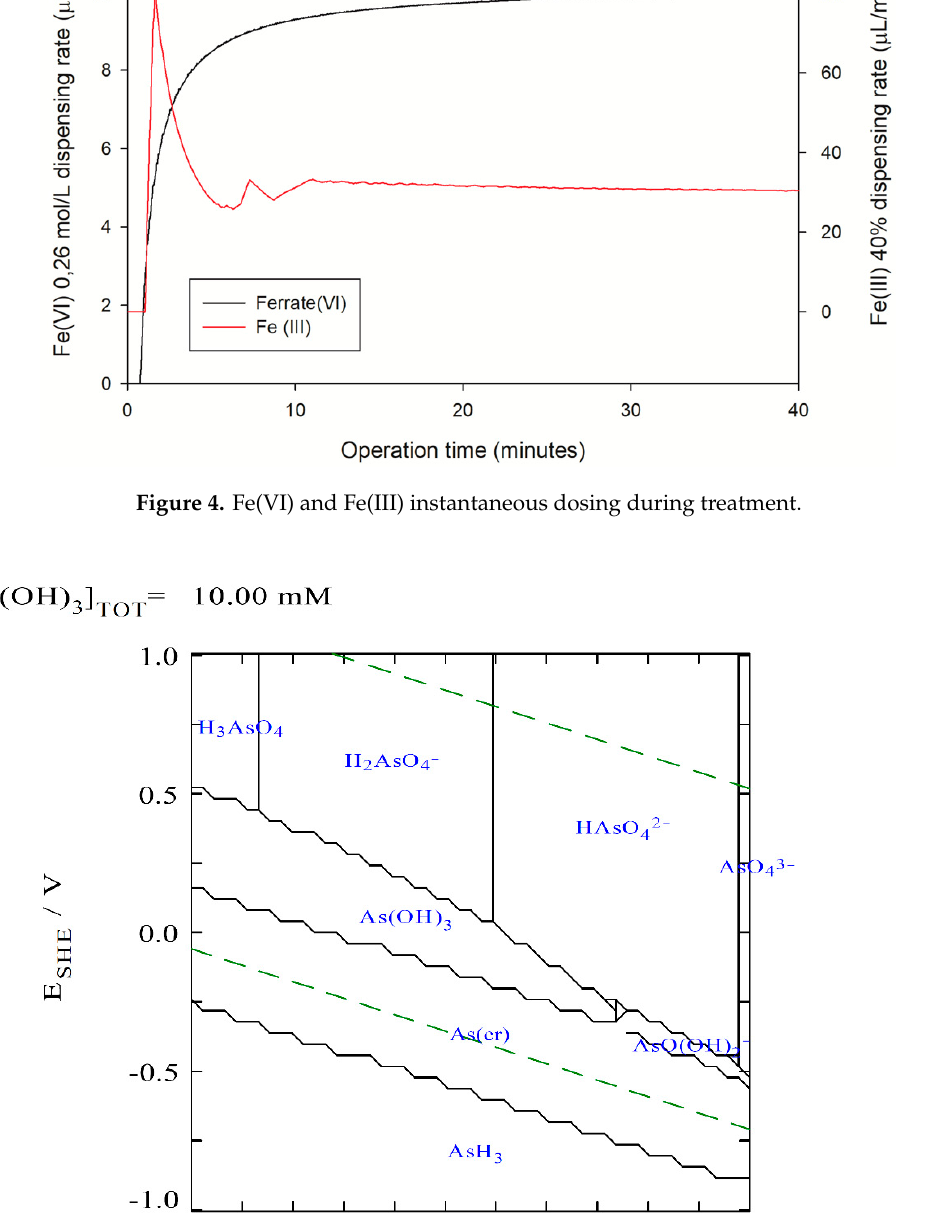
Figure 4. Arsenic predominance diagram at 25 °C produced with the Hydra/Medusa software [31].